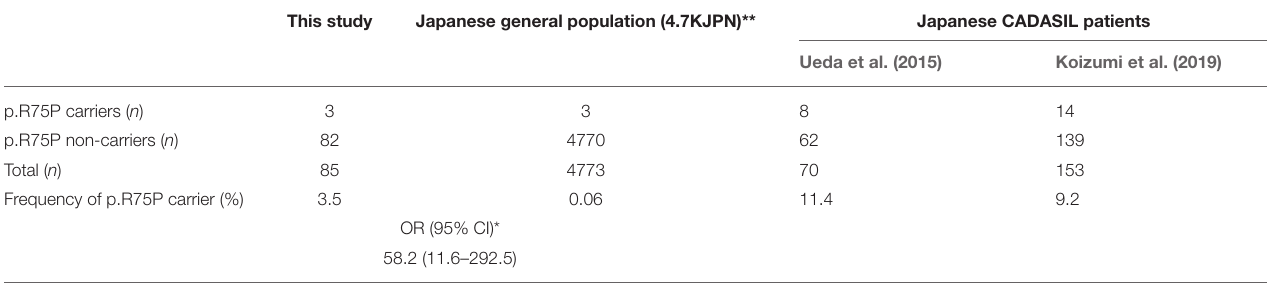
TABLE 3 | Frequency of NOTCH3 p.R75P mutations in patients and